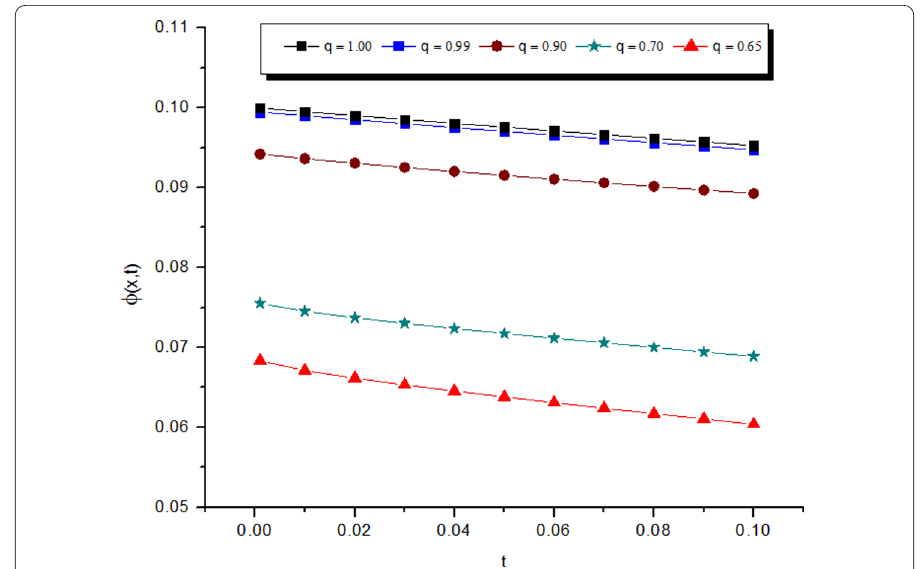
Figure 2 Simulation of φ ( x , t ) for Atangana–Baleanu fractional operator when x = 0.1